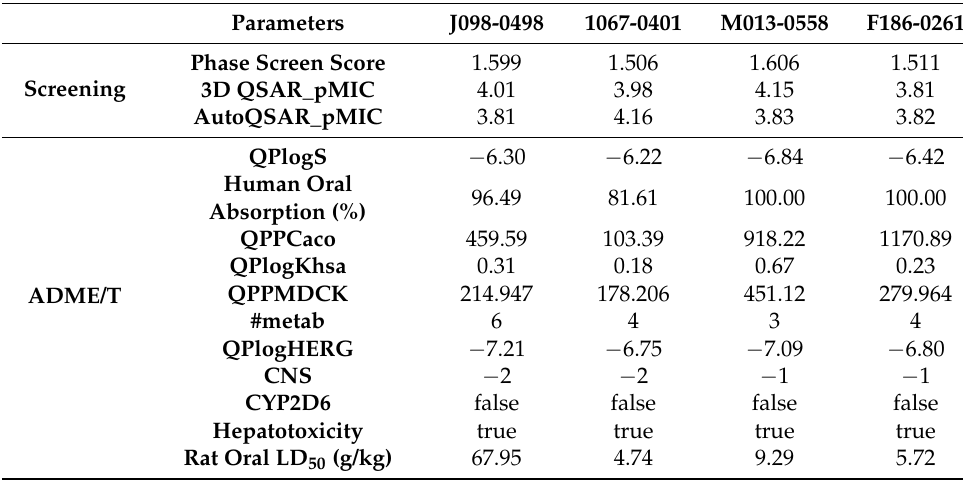
Table 6. Results of 3D-QSAR, auto-QSAR, and ADME/T